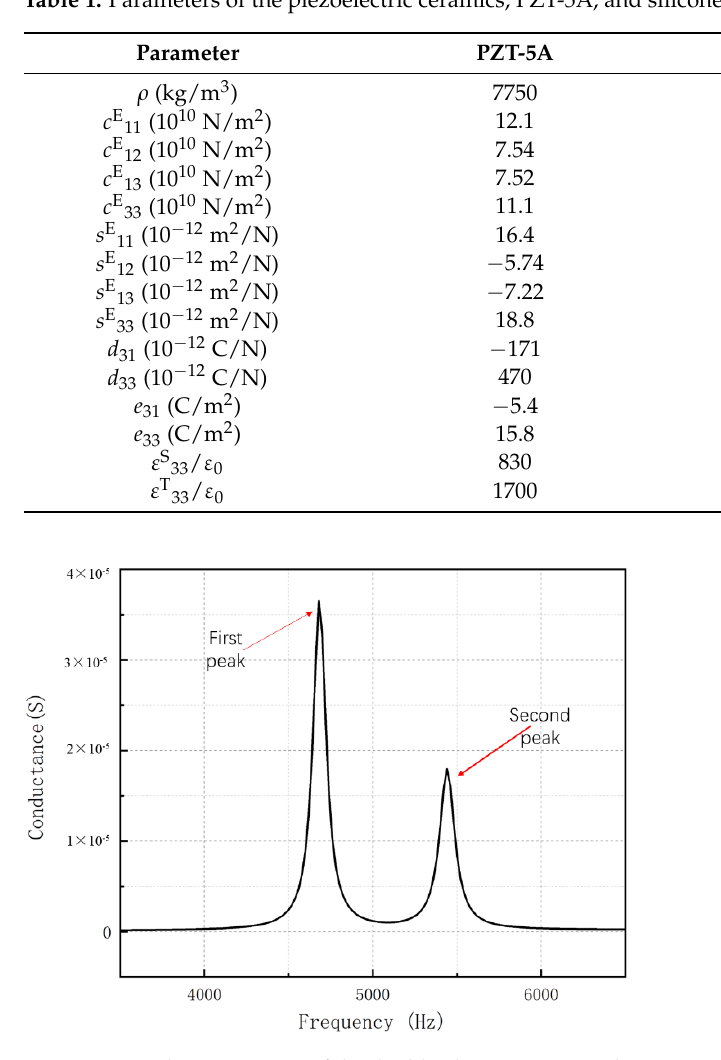
Table 1. Parameters of the piezoelectric ceramics, PZT-5A, and silicone rubber.